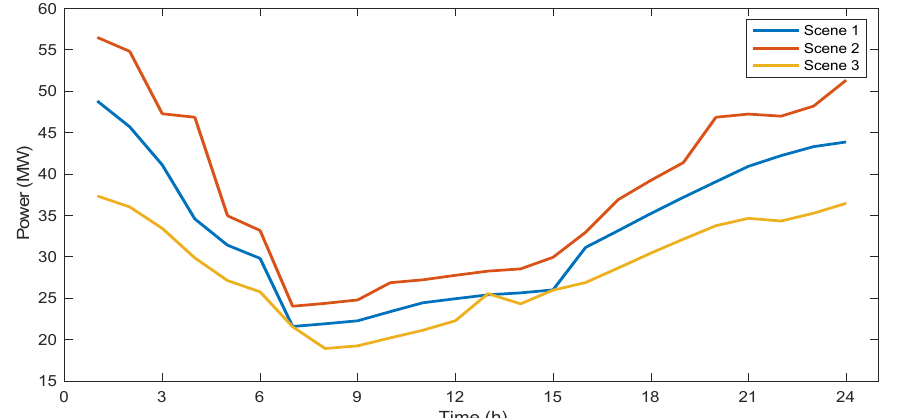
Figure 4. Scene reduction of wind power output.